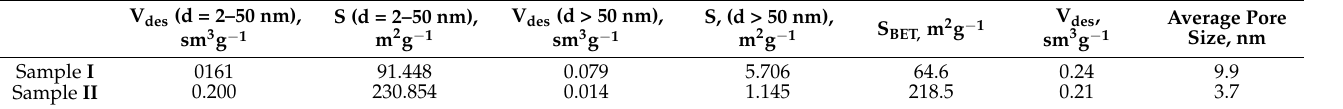
Table 3. Pore size